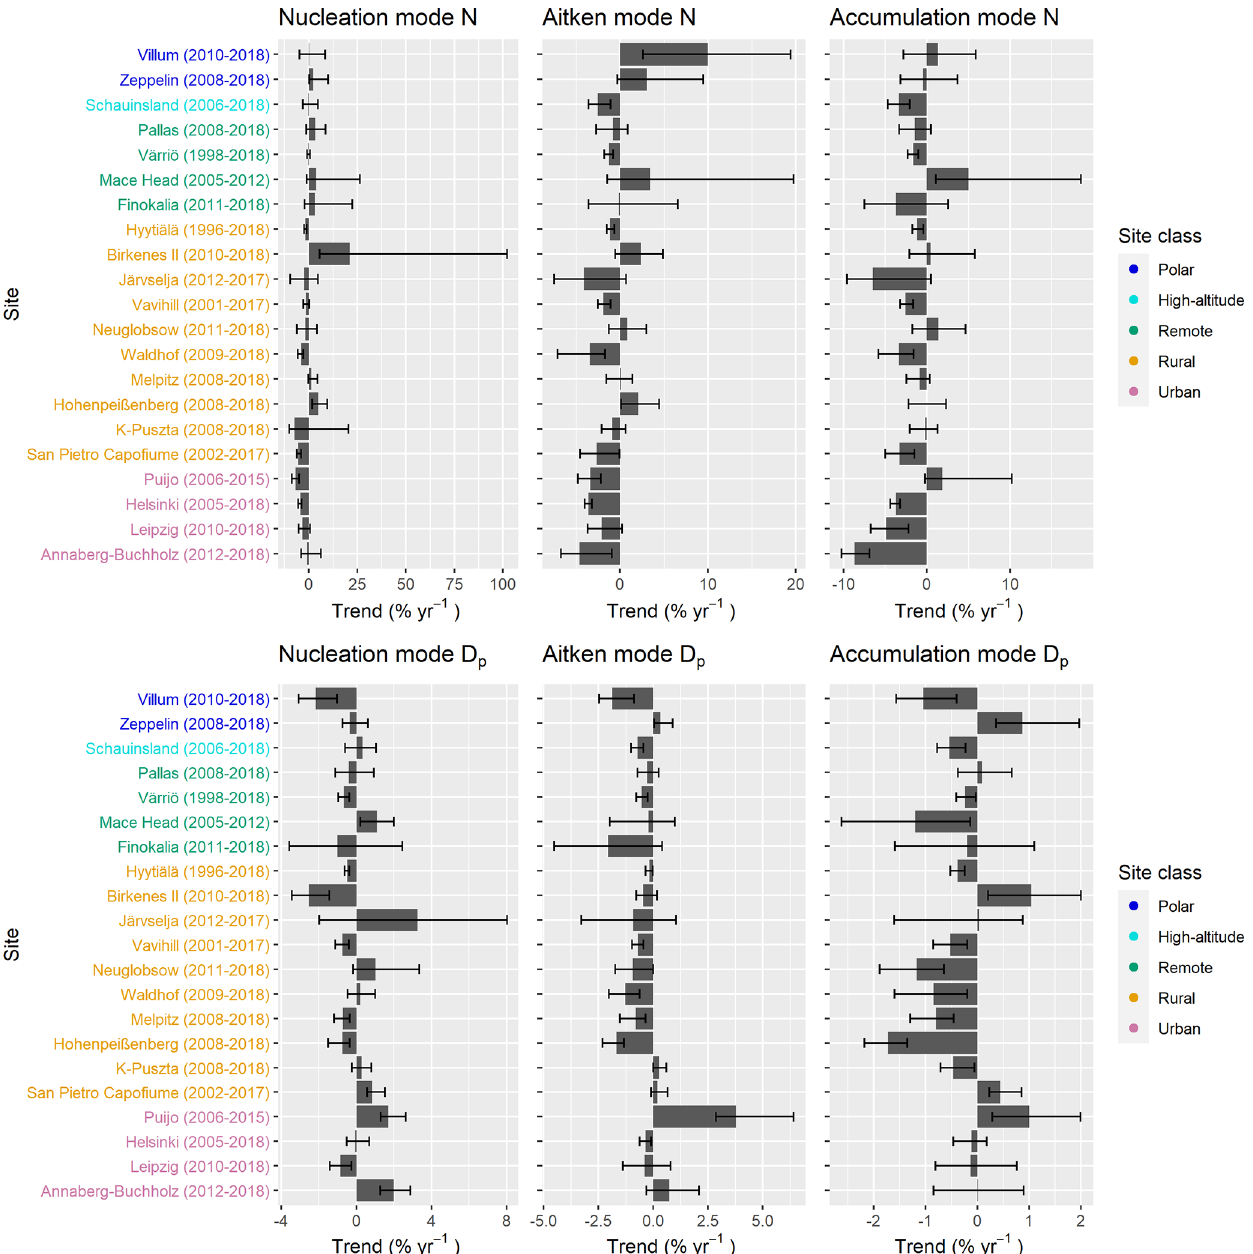
Figure 4. Long-term trend estimators for measured trends of all mode parameters (mean geometric diameter D p , geometric standard devi- ation σ , and number concentration N ) in nucleation (NuclM), Aitken (AitM), and accumulation mode (AccM). Confidence intervals (95% confidence level) are shown with whiskers. Trends have been calculated using the Sen–Theil estimator and complemented with bootstrap confidence intervals (see Sect.